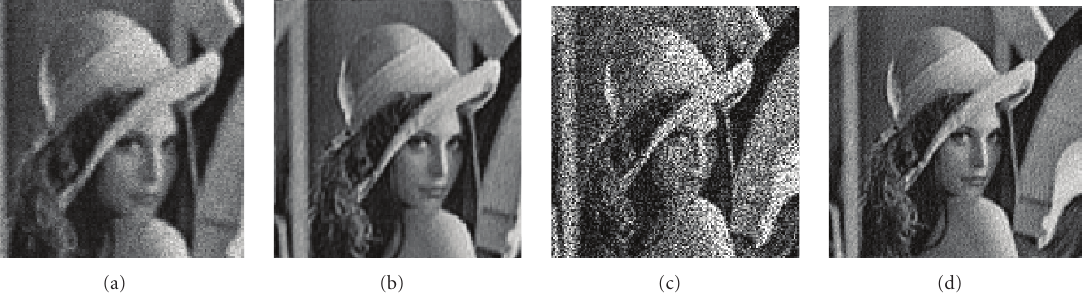
Figure 2: Restoration results in Poisson noise scenario (a) Blurred Image, (b) Wiener, (c) Inverse, (d) CLS restored images.